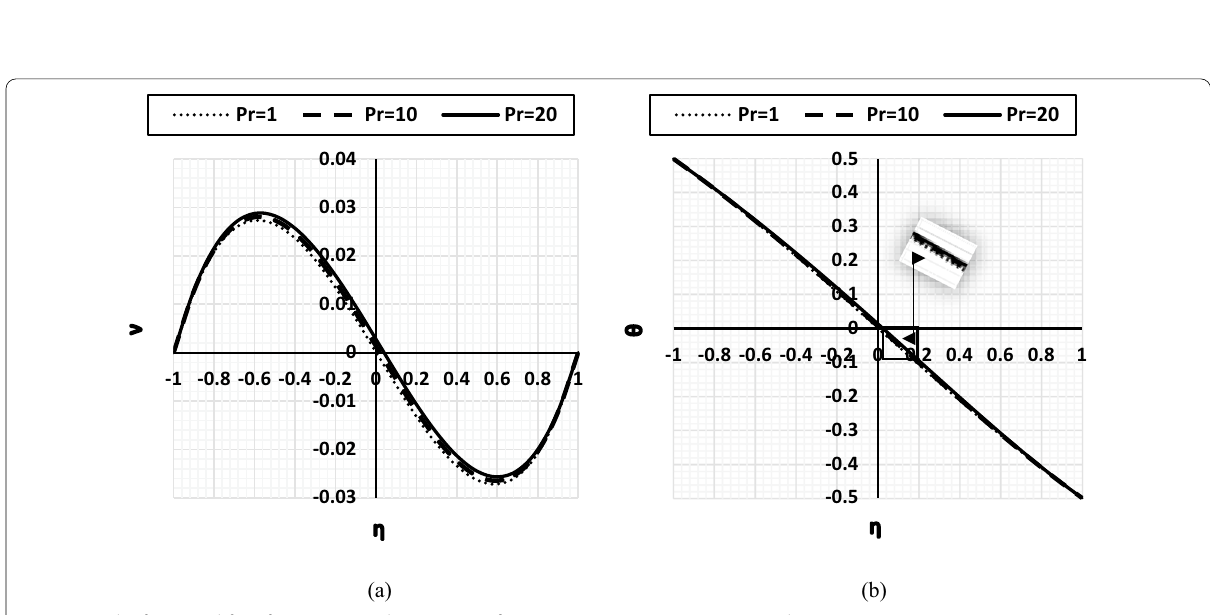
Fig. 5 Result of V ( η ) and θ ( η ) for various Pr when ϕ